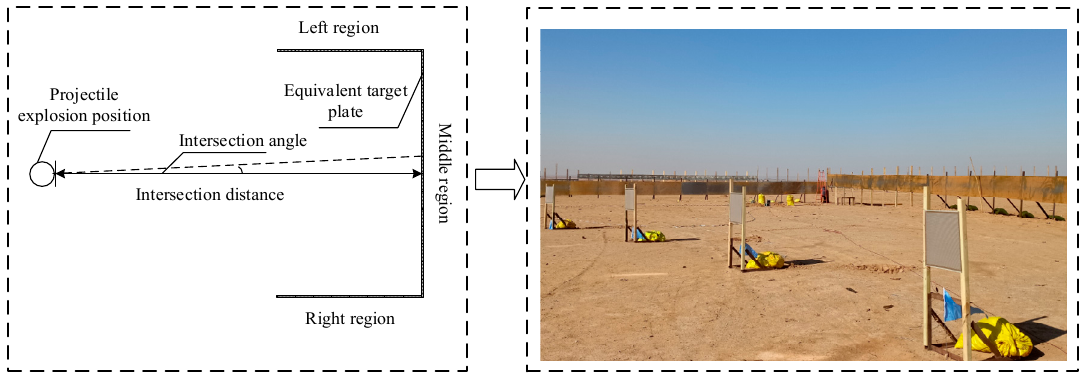
Figure 7. Test layout